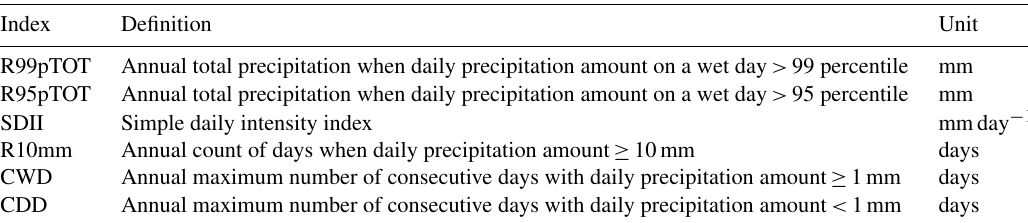
Table 4. Definition of extreme precipitation indices used in the analysis.